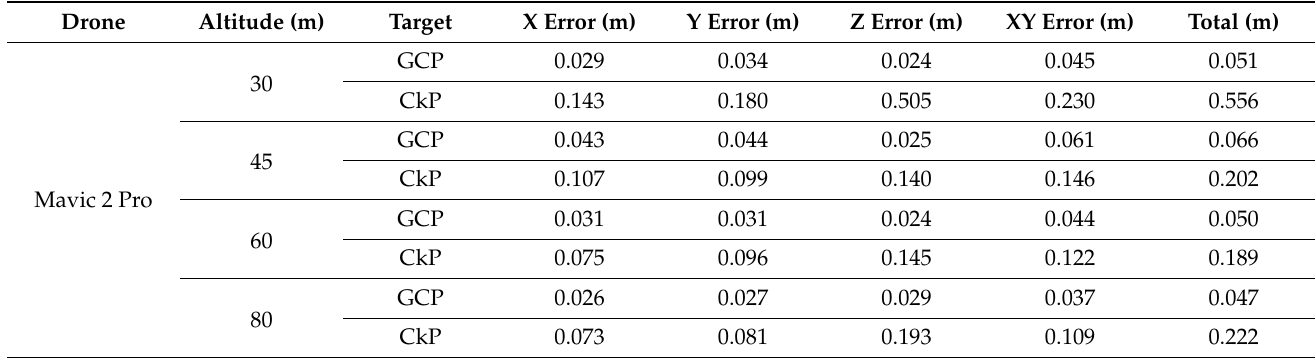
Table 4. Residuals on GCP and CkP for the survey made by the Mavic 2 Pro at different AGLs. Total represents the total error of the 3 components.